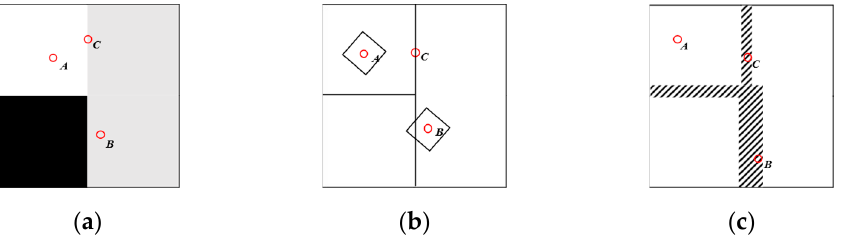
Figure 3. Two different ways of interpreting the edges of an image. ( a ) test image; ( b ) canny edge;